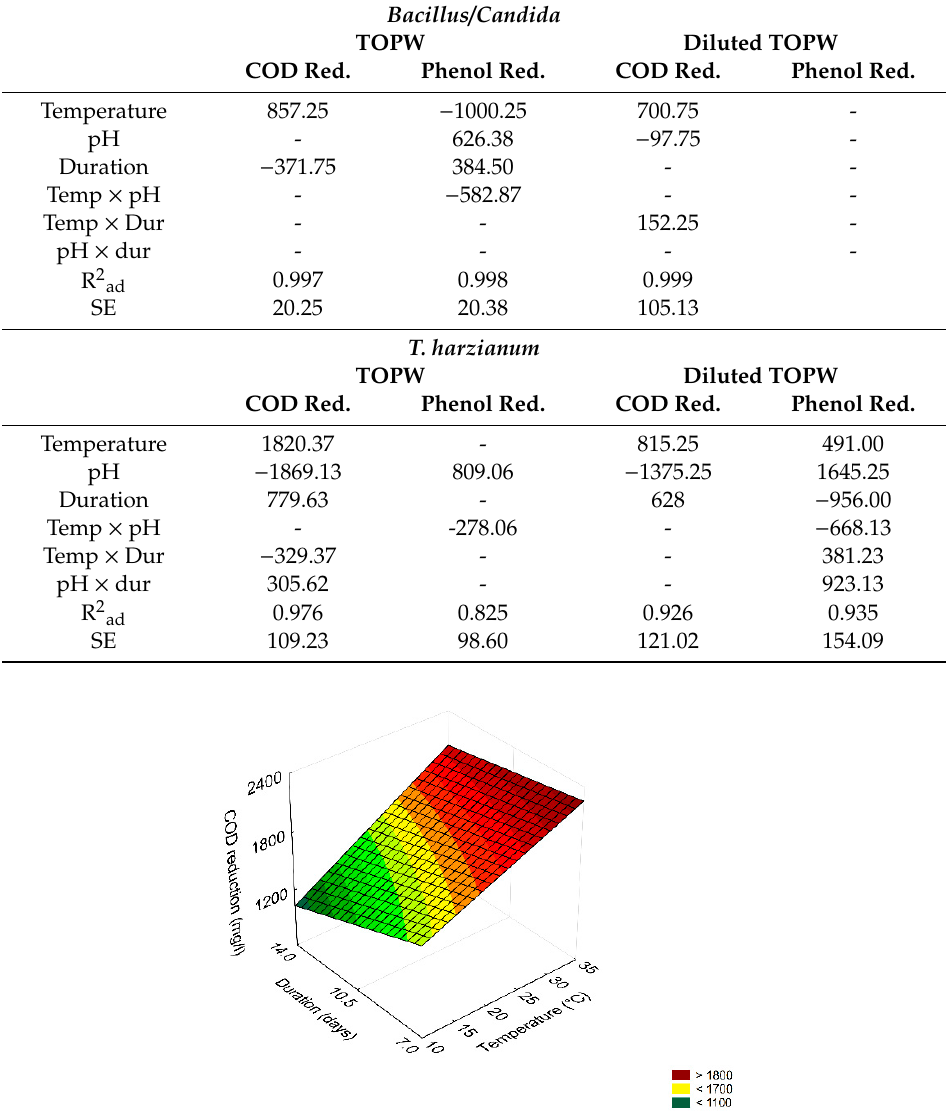
Table 3. Effect of pH, temperature and duration, as single or interactive terms, on the reduction of COD and phenols by Bacillus / Candida and T. harzianum in TOPW and diluted TOPW from green olive production. R 2ad , adjusted determination coefficient. SE, standard error.